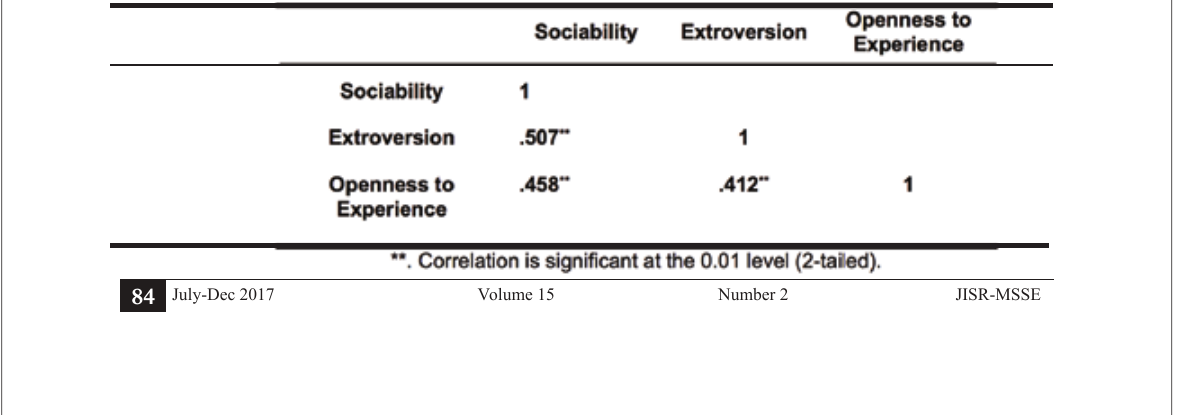
Table 6: Correlation